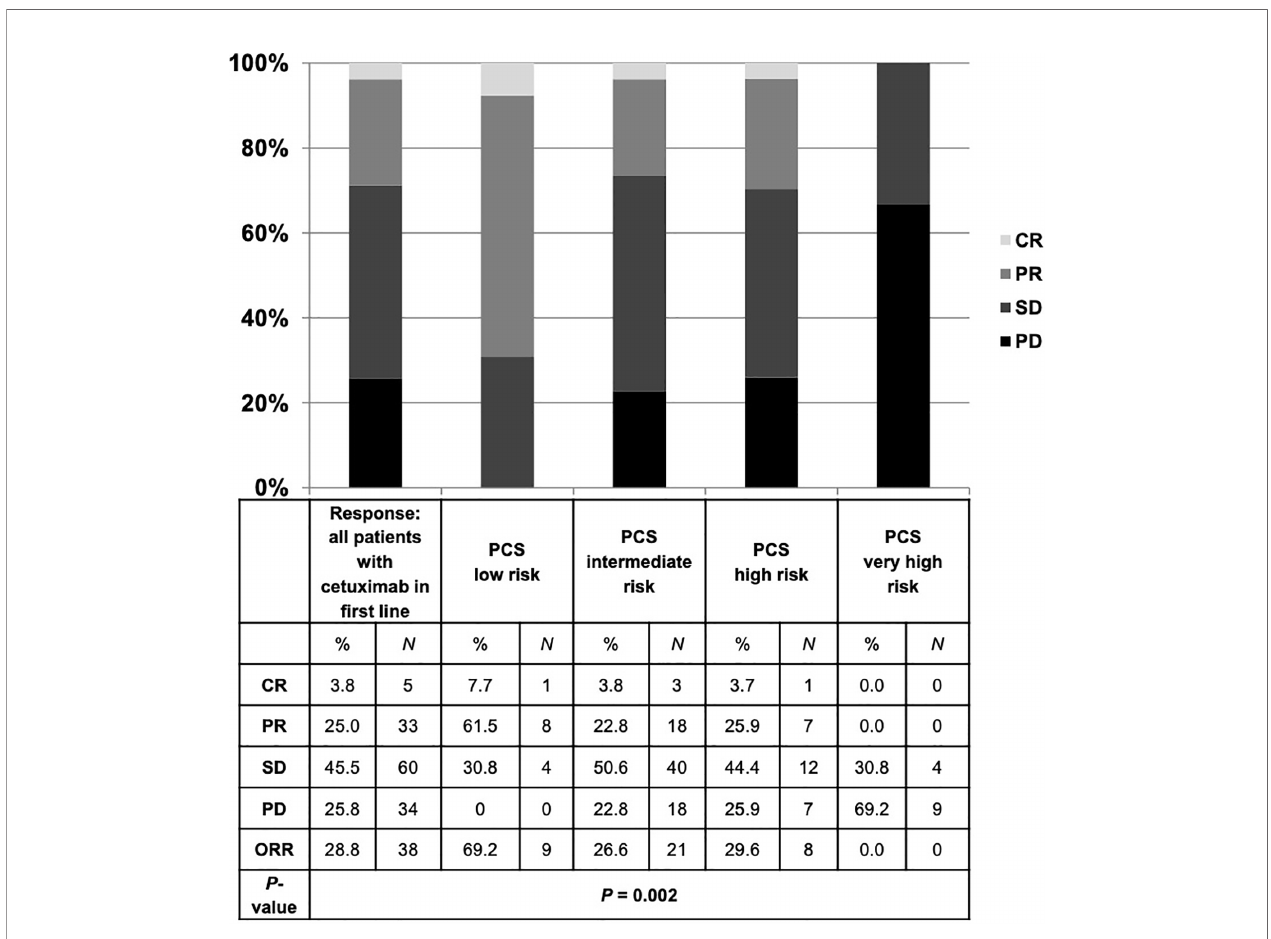
FIGURE 8 | Best response to cetuximab-based fi rst-line therapy for all patients and in each risk group of the prognostic clinical score (PCS). Patients with low risk PCS had a favorable overall response rate (ORR) of 69.2% and disease control rate (DCR) of 100%, whereas no objective response was detected in the very high risk group. CR, complete remission; PR, partial remission; SD, stable disease; PD, progressive